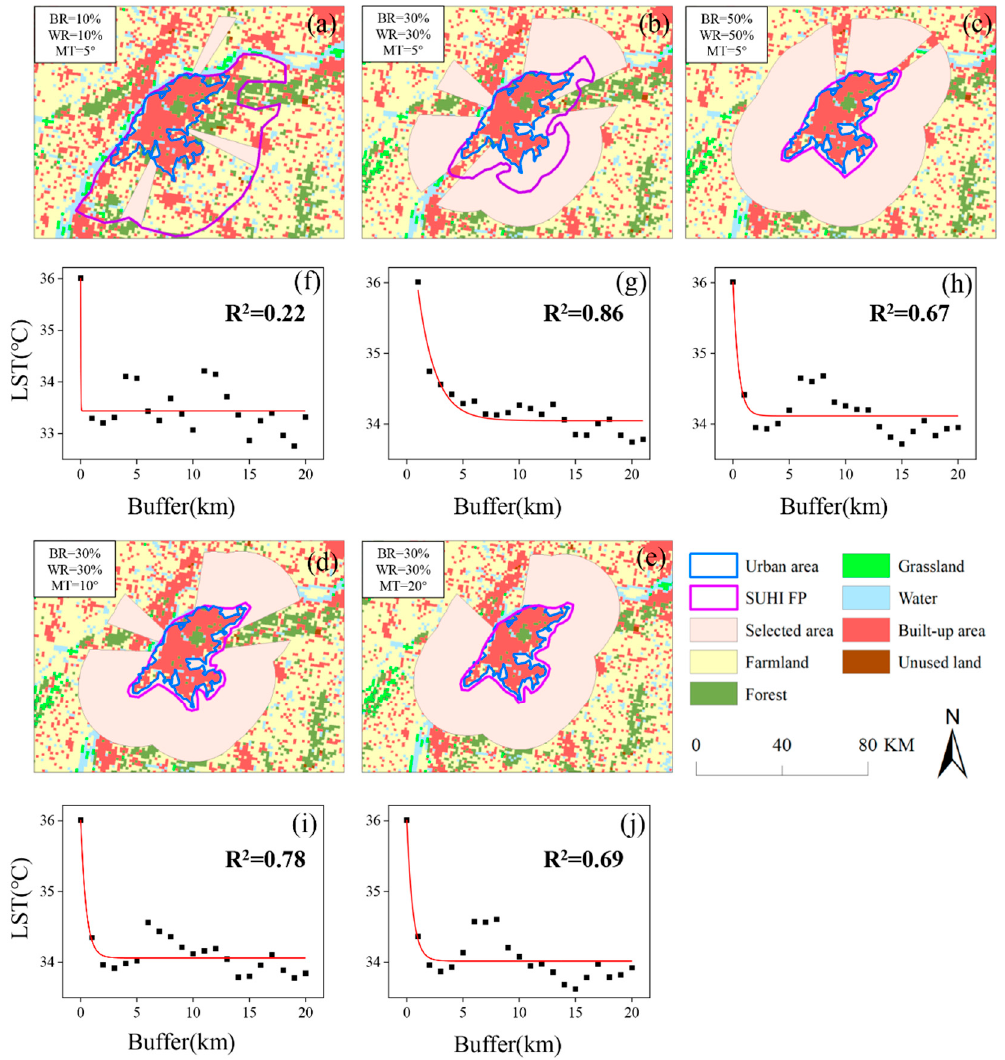
Figure 11. Suburban area, footprint, and land surface temperature fitting curves of Nanjing selected by different BR, WR, and MT. ( a – e ) Selected suburban area and footprint; ( f – j ) corresponding temperature fitting curves.